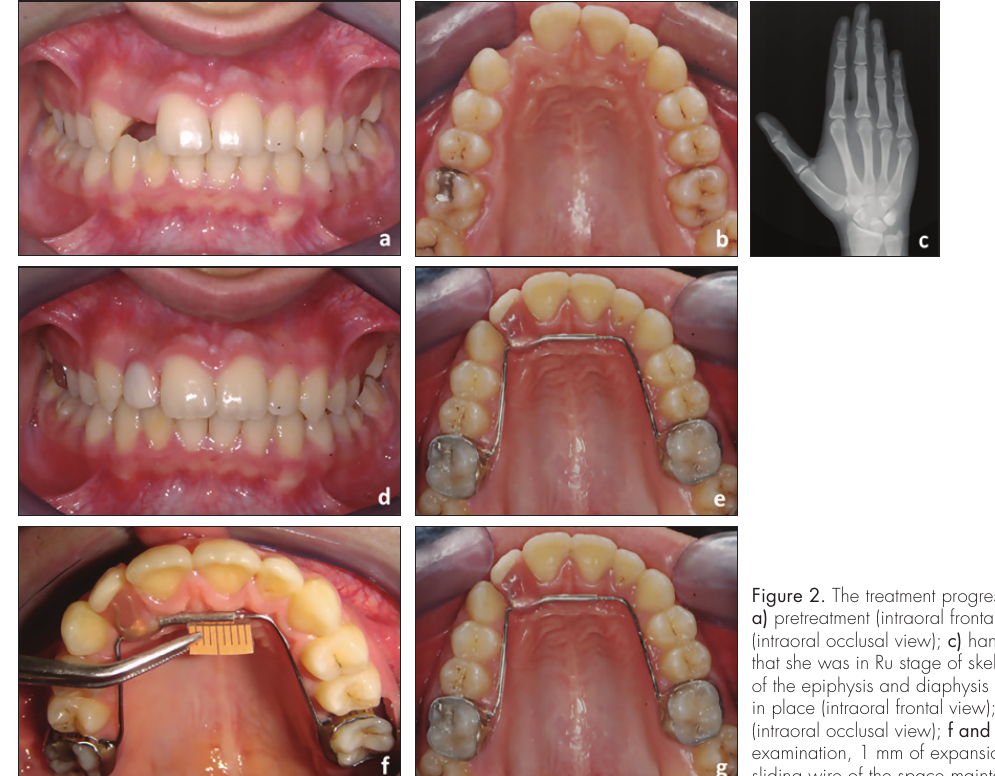
Figure 2. The treatment progress of Patient 1: a) pretreatment (intraoral frontal view); b) pretreatment (intraoral occlusal view); c) hand-wrist radiograph revealed that she was in Ru stage of skeletal development (union of the epiphysis and diaphysis of radius); d) appliance in place (intraoral frontal view); e) appliance in place (intraoral occlusal view); f and g) at 18-month clinical examination, 1 mm of expansion was observed on the sliding wire of the space